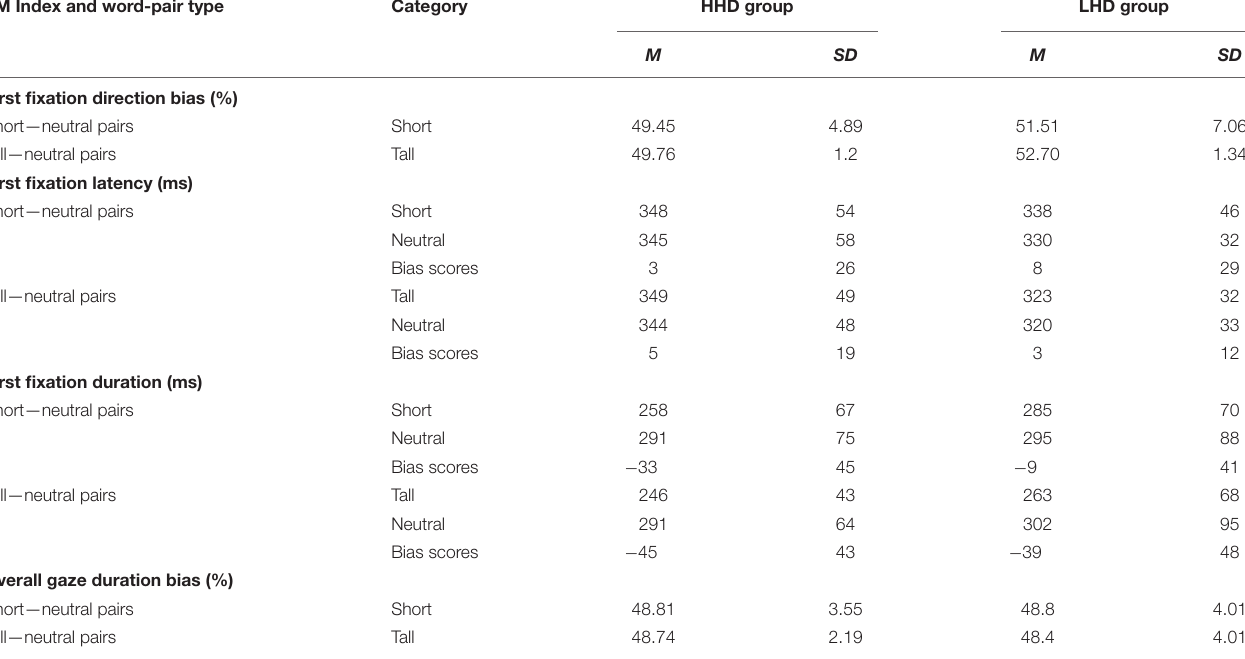
TABLE 2 | Eye movement data of height-related words in the HHD and LHD groups.